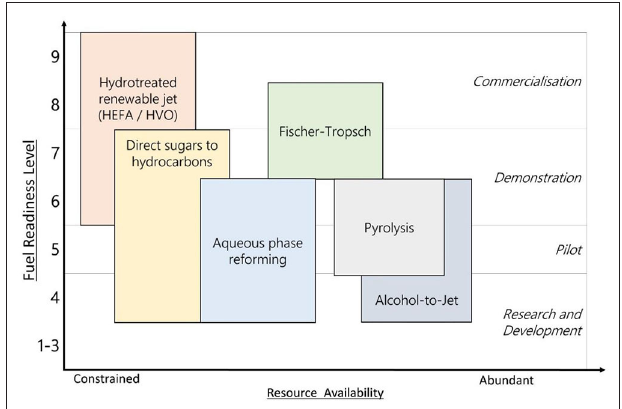
FIGURE 5 | Future scope for adapting processes to a commercial level based on resource availability and technology maturity (Drawn using data